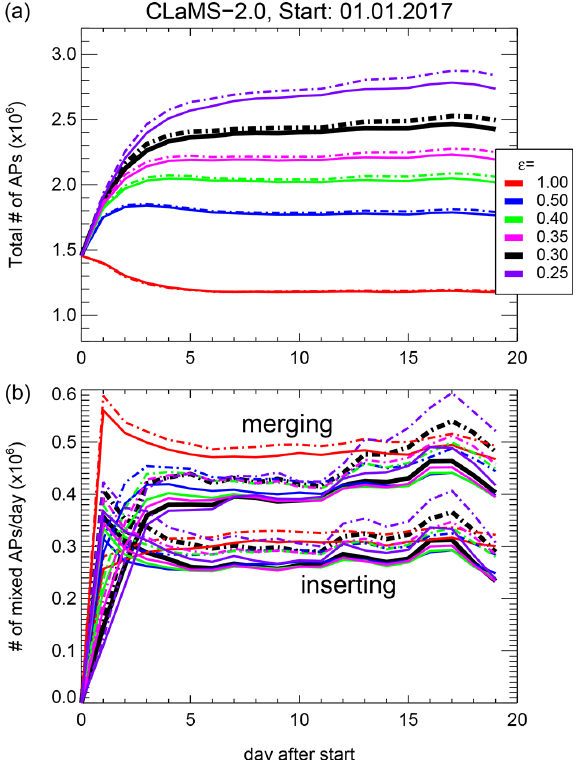
Figure A3. Tuning of (cid:15) for runs with (cid:49)t = 6h, λ = 4 . 0d − 1 . Here different values of (cid:15) are used, from (cid:15) = 1 (CLaMS 1.0) to (cid:15) = 0 . 25. To get the total number of APs which is similar to that in CLaMS 1.0 reference run, (cid:15) = 0 . 3 is recommended (black). Solid and dashed lines denote the EI- and E5-driven runs,